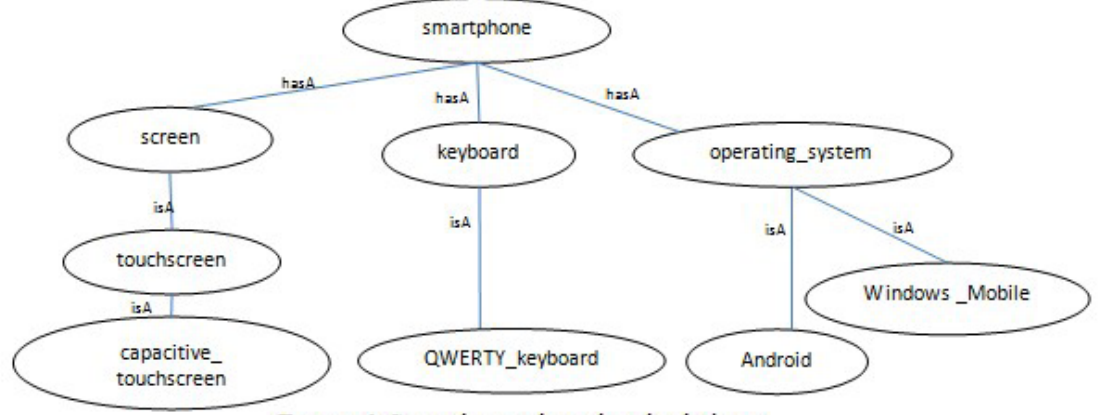
Figure 6 is an illustration of some top extracted conceptual relations in the computer learned ontology being translated into